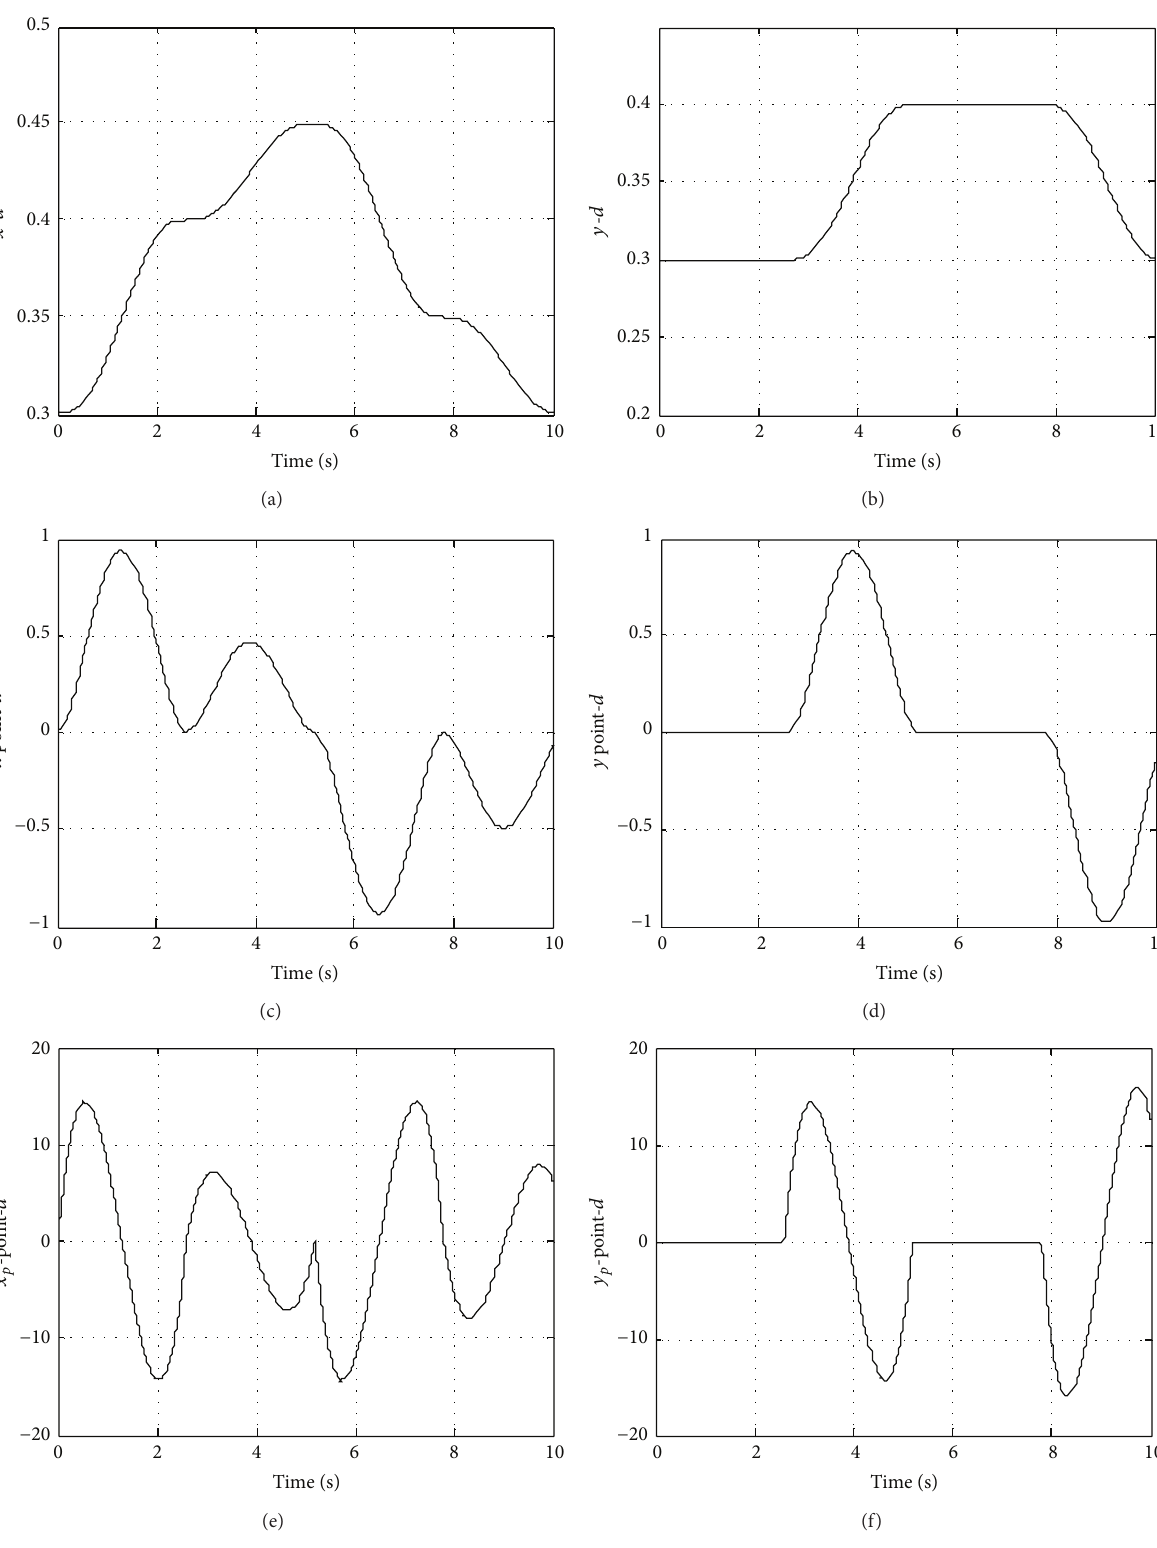
Figure 5: Desired workspace trajectory: (a)-(b) position trajectory, (c)-(d) velocity trajectories, and (e)-(f) acceleration